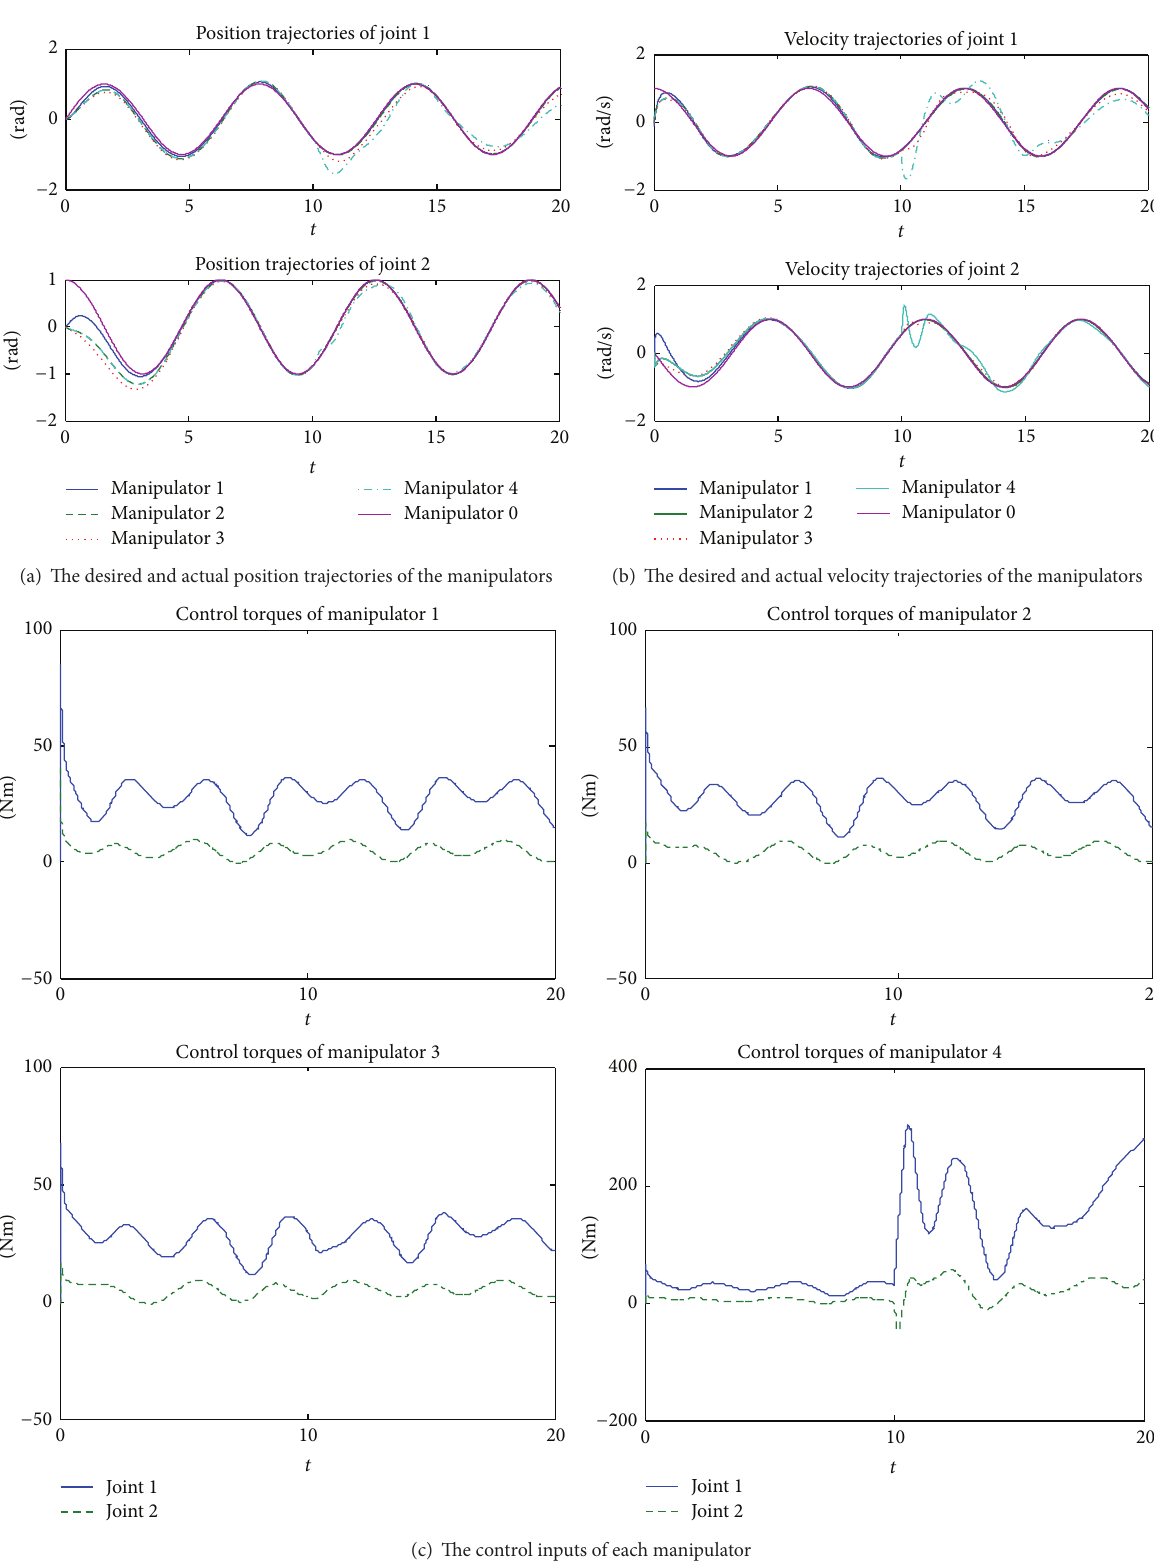
Figure 3: Simulation results with the actuator faults under the nominal